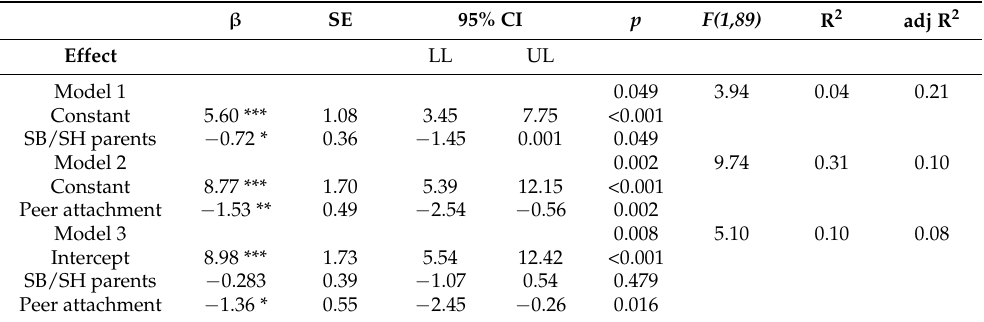
Table 2. Models of prediction of teenagers’ withdrawal a based on the predictors: parent and peer attachment b representations.